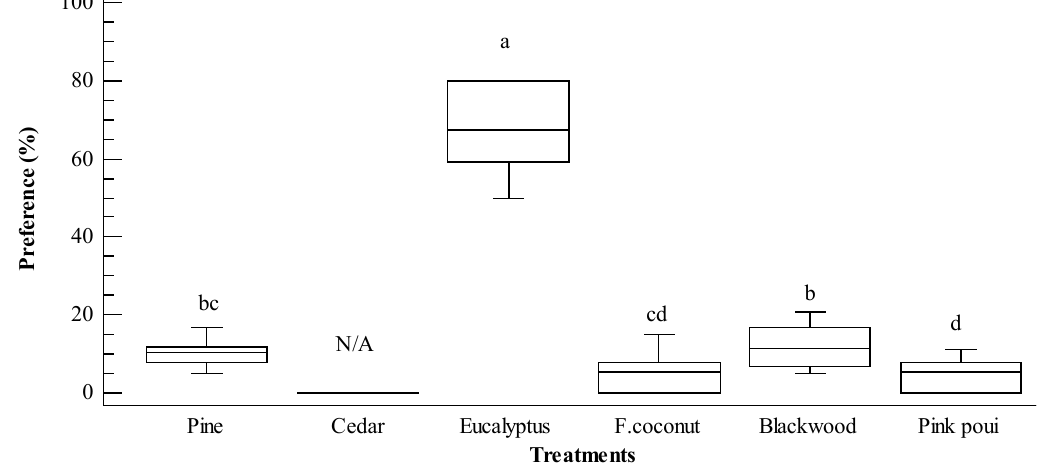
Fig 3 . Percentage of preference of Coptotermes testaceus workers 24 hours after being exposed to six substrates (woods), at an RH of 100% and a temperature of 20 °C, n = 10. Different letters indicate significant differences between